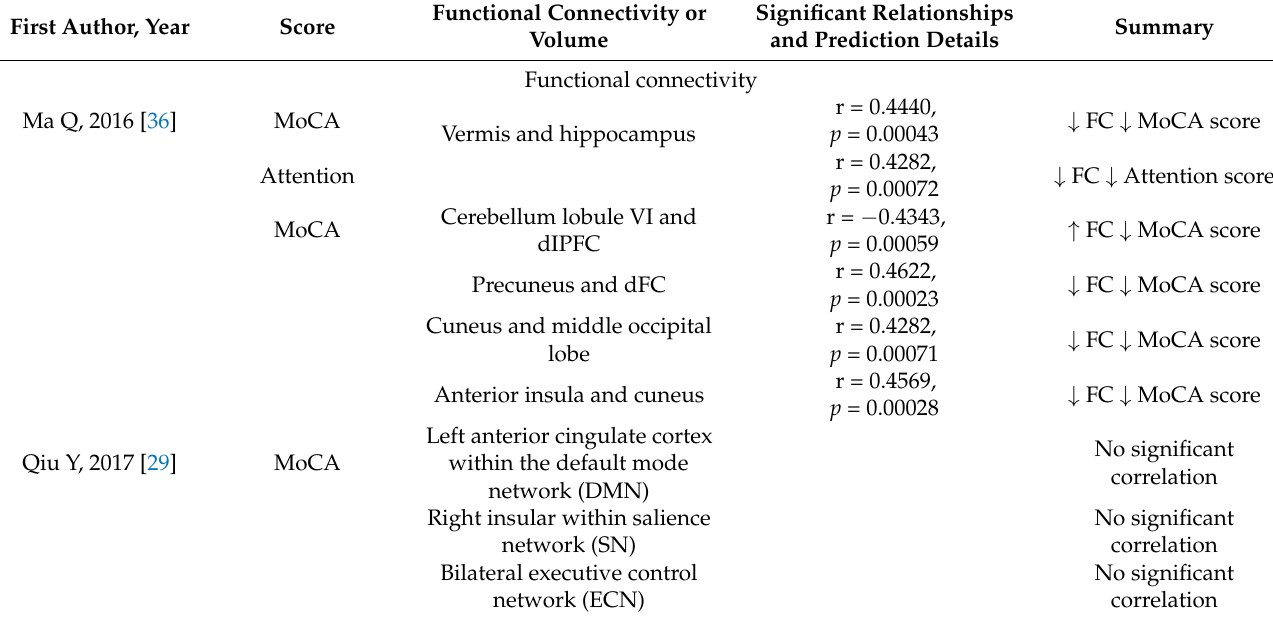
Table 3. Relationship of neurocognitive outcome to MRI